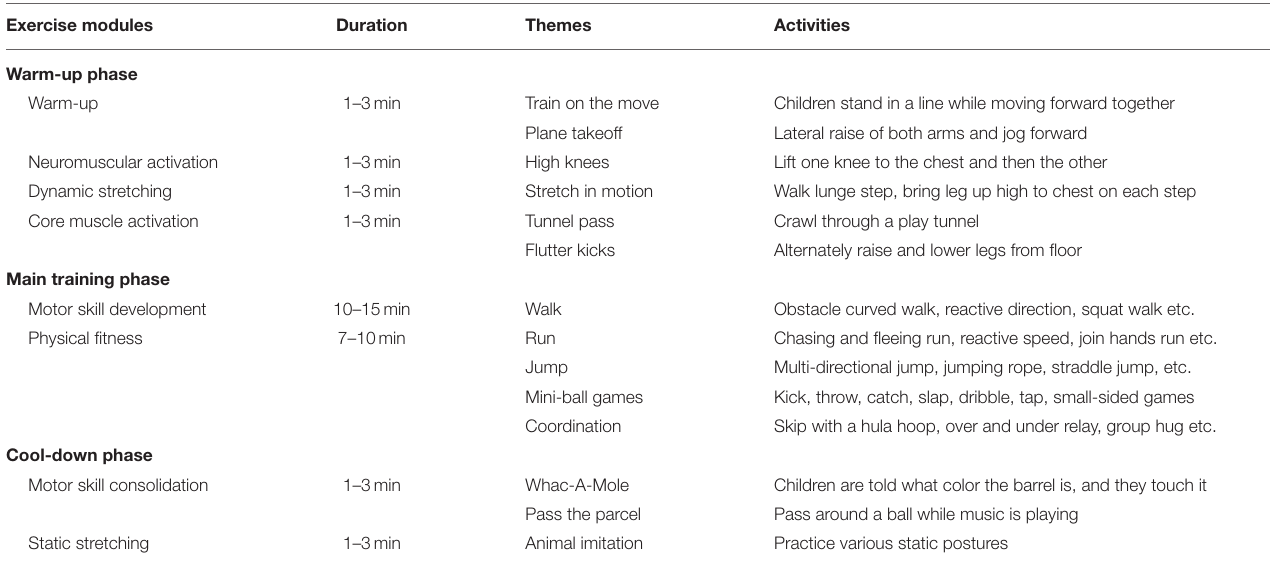
TABLE 3 | Description of the functional training